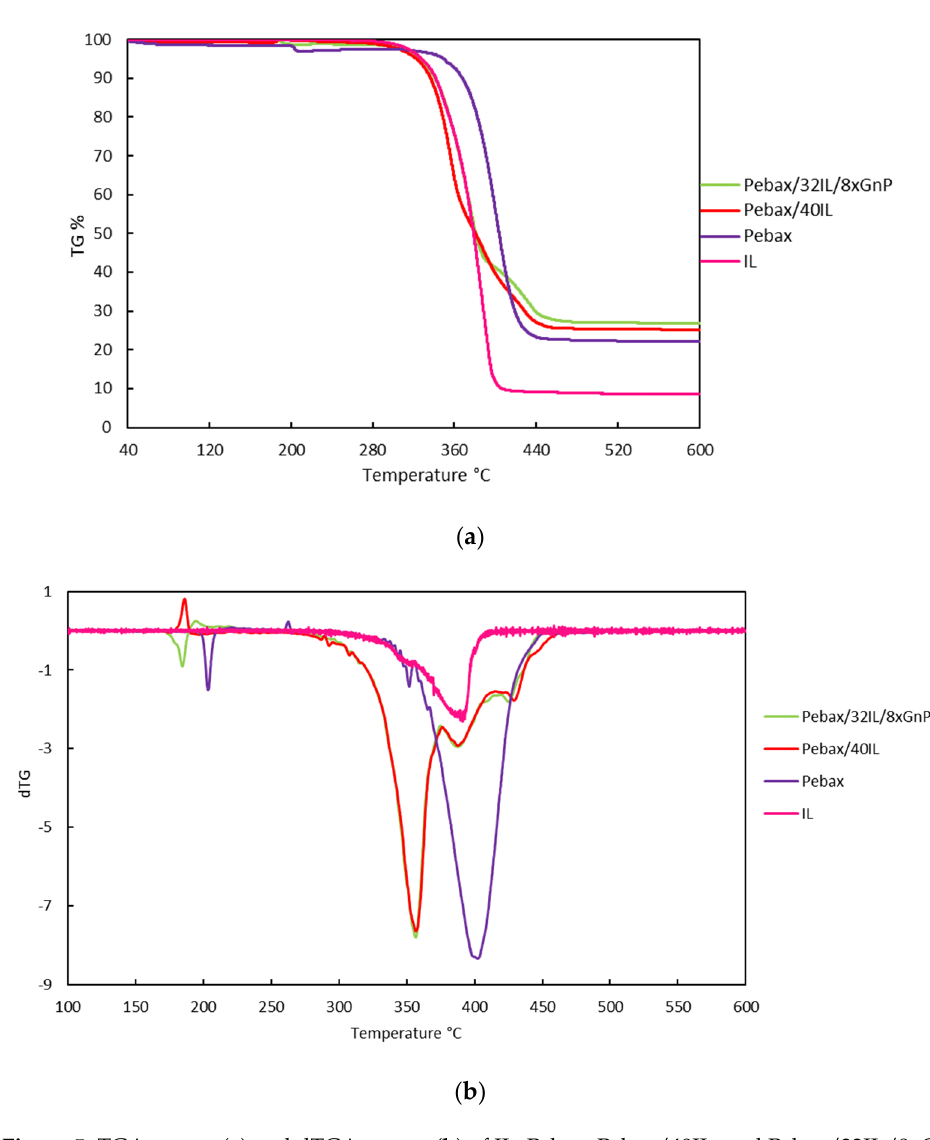
Figure 5. TGA curves ( a ) and dTGA curves ( b ) of IL, Pebax; Pebax/40IL; and Pebax/32IL/8xGnP— full names in Table 1. Table 2. Thermal properties obtained by TGA, temperature at which degradation begins; T Start , temperature at which degradation ends; T Dec , and the onset temperature; T Onset , of the different